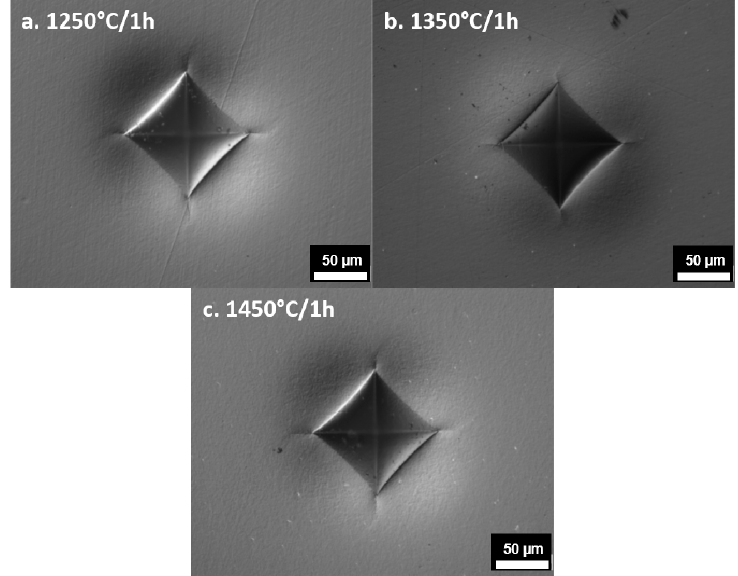
Figure 3. HV10 Vickers hardness indents with crack profile and uplifted zones of 2Y-TZP sintered at ( a ) 1250 °C, ( b ) 1350 °C, and ( c ) 1450 °C.